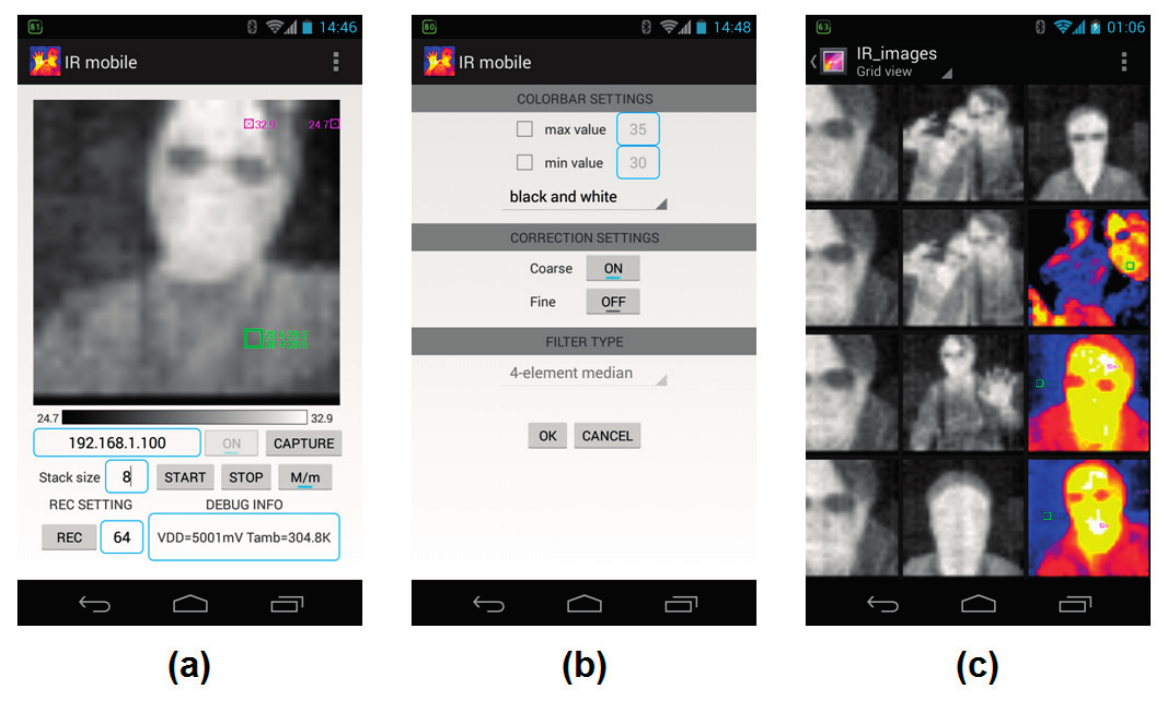
Figure 4. The graphic user interface of IR imaging application software (IRAPP). ( a ) The main page; ( b ) the settings page; and ( c ) the captured images stored in the micro SD